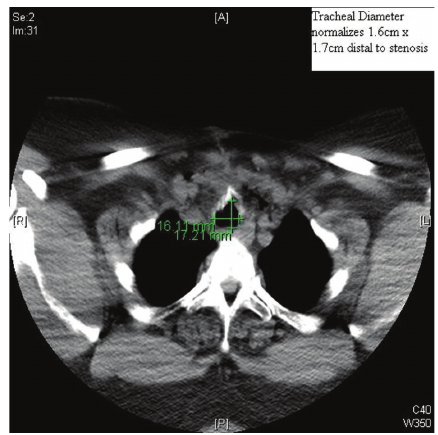
Figure 2: CT SCAN of tracheal